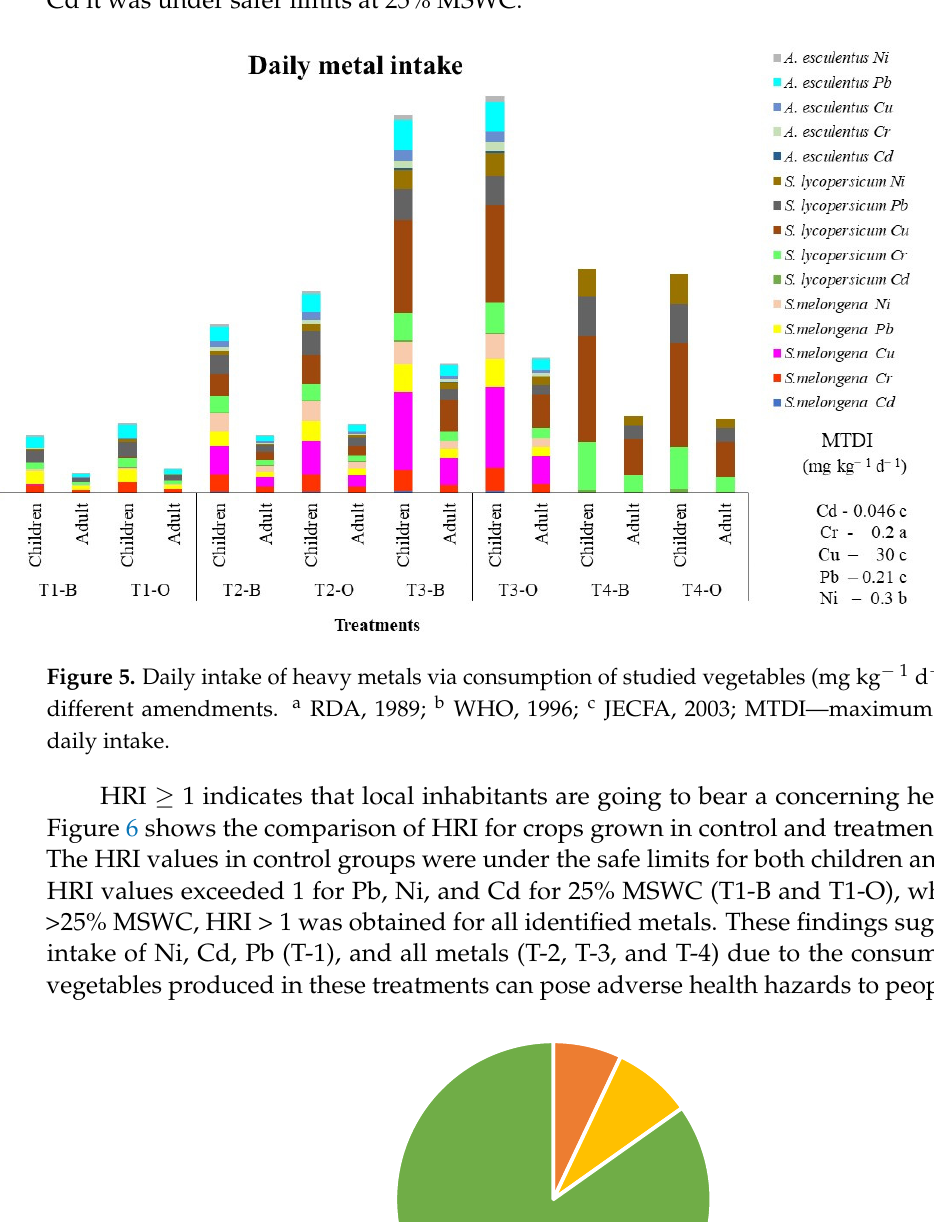
Figure 4. BCF of ( A ) S. melongena , ( B ) S. lycopersicum , and ( C ) A. esculentus under different MSWC concentrations, noted as 0(T0), 1(T1-B), 2(T1-O), 3(T2-B), 4(T2-O), 5(T3-B), 6(T3-O), 7(T4-B), and 8(T4-O). Cd it was under safer limits at 25% MSWC.